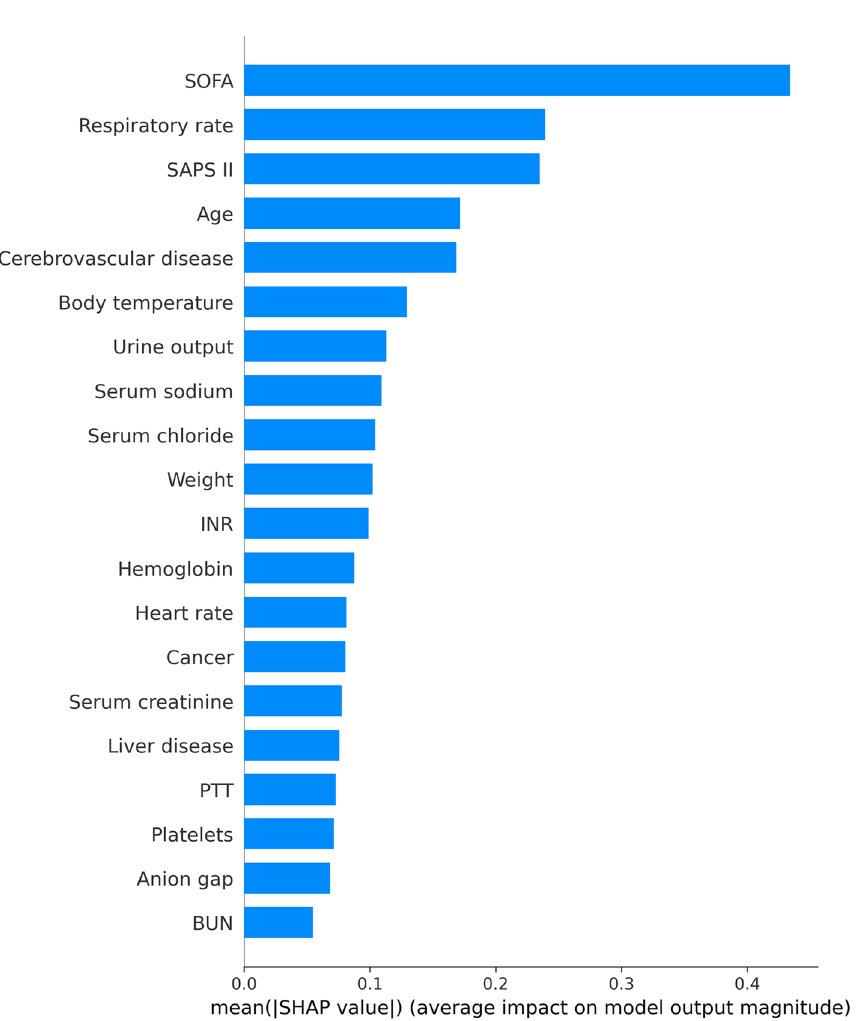
Figure 3. The top 20 important features derived from the XGBoost model. SHAP indicates the importance ranking of features. The significance of each covariate in the construction of the final predictive model is represented by the matrix plot. SHAP SHapley additive explanation, SOFA Sequential organ failure assessment, SAPS II Simplified acute physiology score II, INR International normalized ratio, PTT Partial thromboplastin time, BUN Blood urea